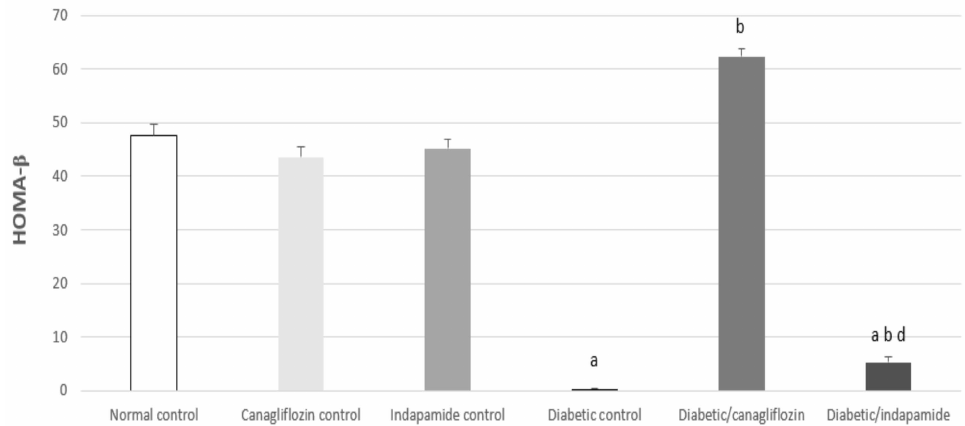
Figure 5. Impact of daily CANA and INDA treatment on HOMA- β : oral CANA and INDA treatments were initiated once daily for 4 weeks. Data represent the mean ± S.E.M. (6 rats/group). ANOVA followed by post hoc Tukey–Kramer test at ( p < 0.05) was used for statistical comparison; a against normal CTRL, b against diabetic CTRL, d against